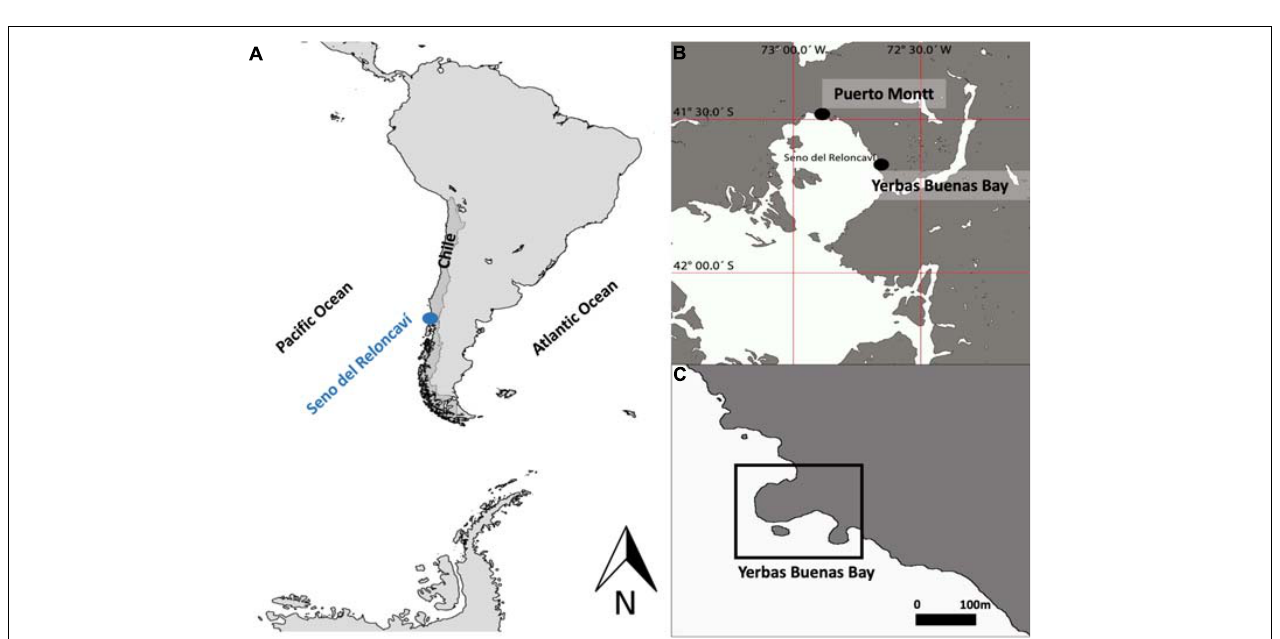
FIGURE 2 | South America (A) Seno del Reloncaví and (B) the study site at Yerbas Buenas Bay (C) .